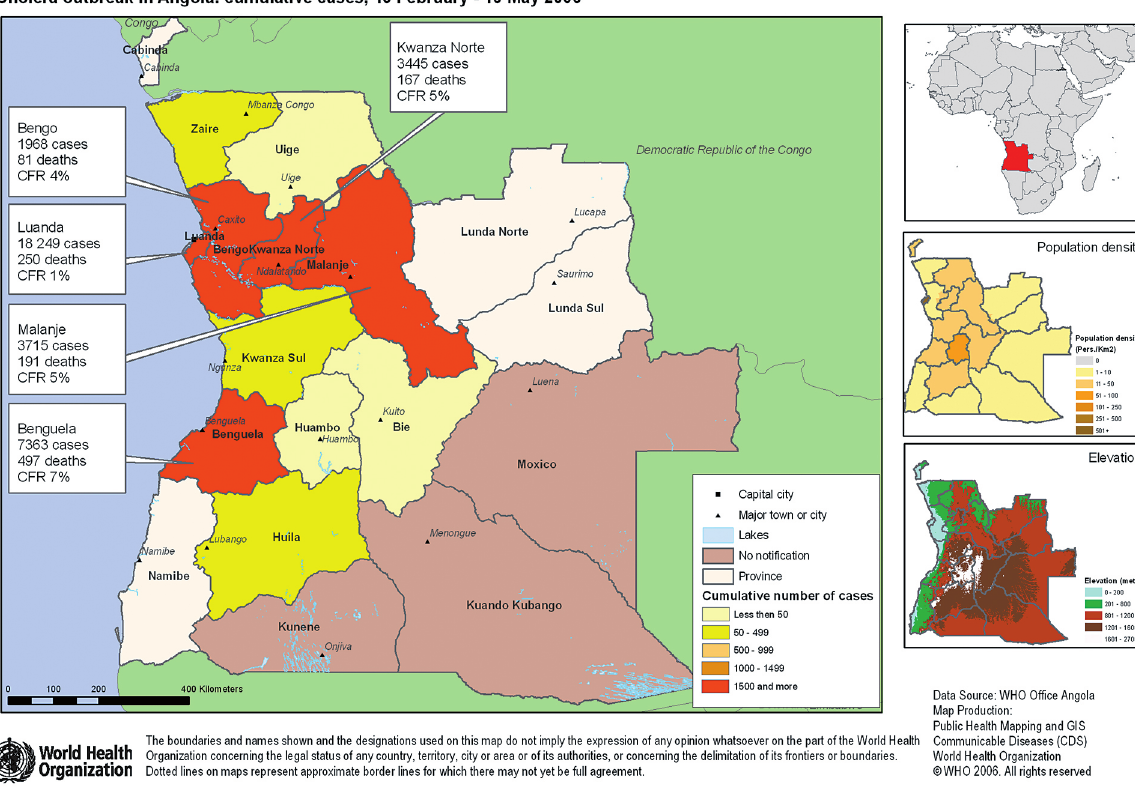
Fig. 1. Map of cholera outbreak in Angola in 2006 (WHO GHA 2011). Notes: